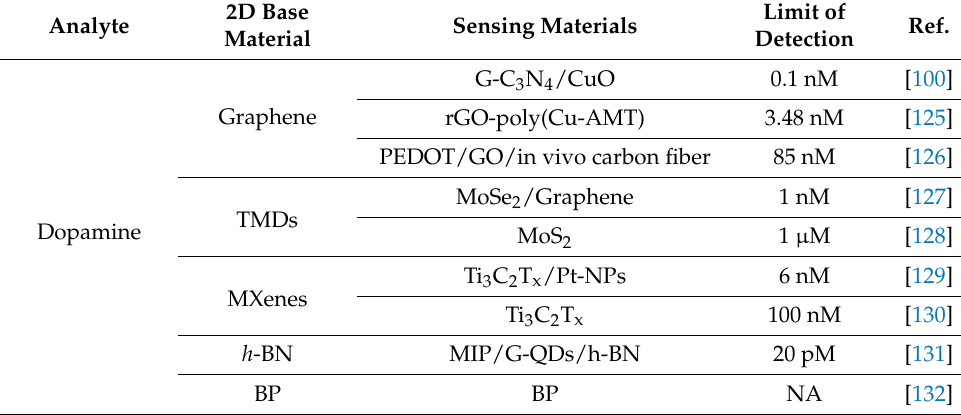
Sensing Materials